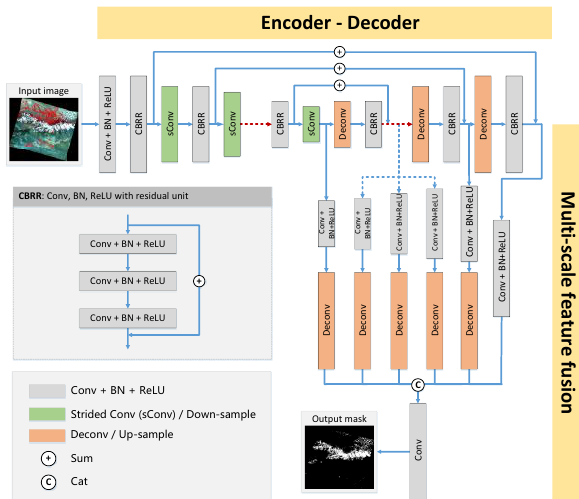
Figure 1. The architecture of the proposed MSCN. Feature maps with different scales are concatenated and fused. The output feature map of the final convolutional layer is regarded as cloud probability map and is fed to a binary classifier for pixel-wise binary cloud mask segmentation.